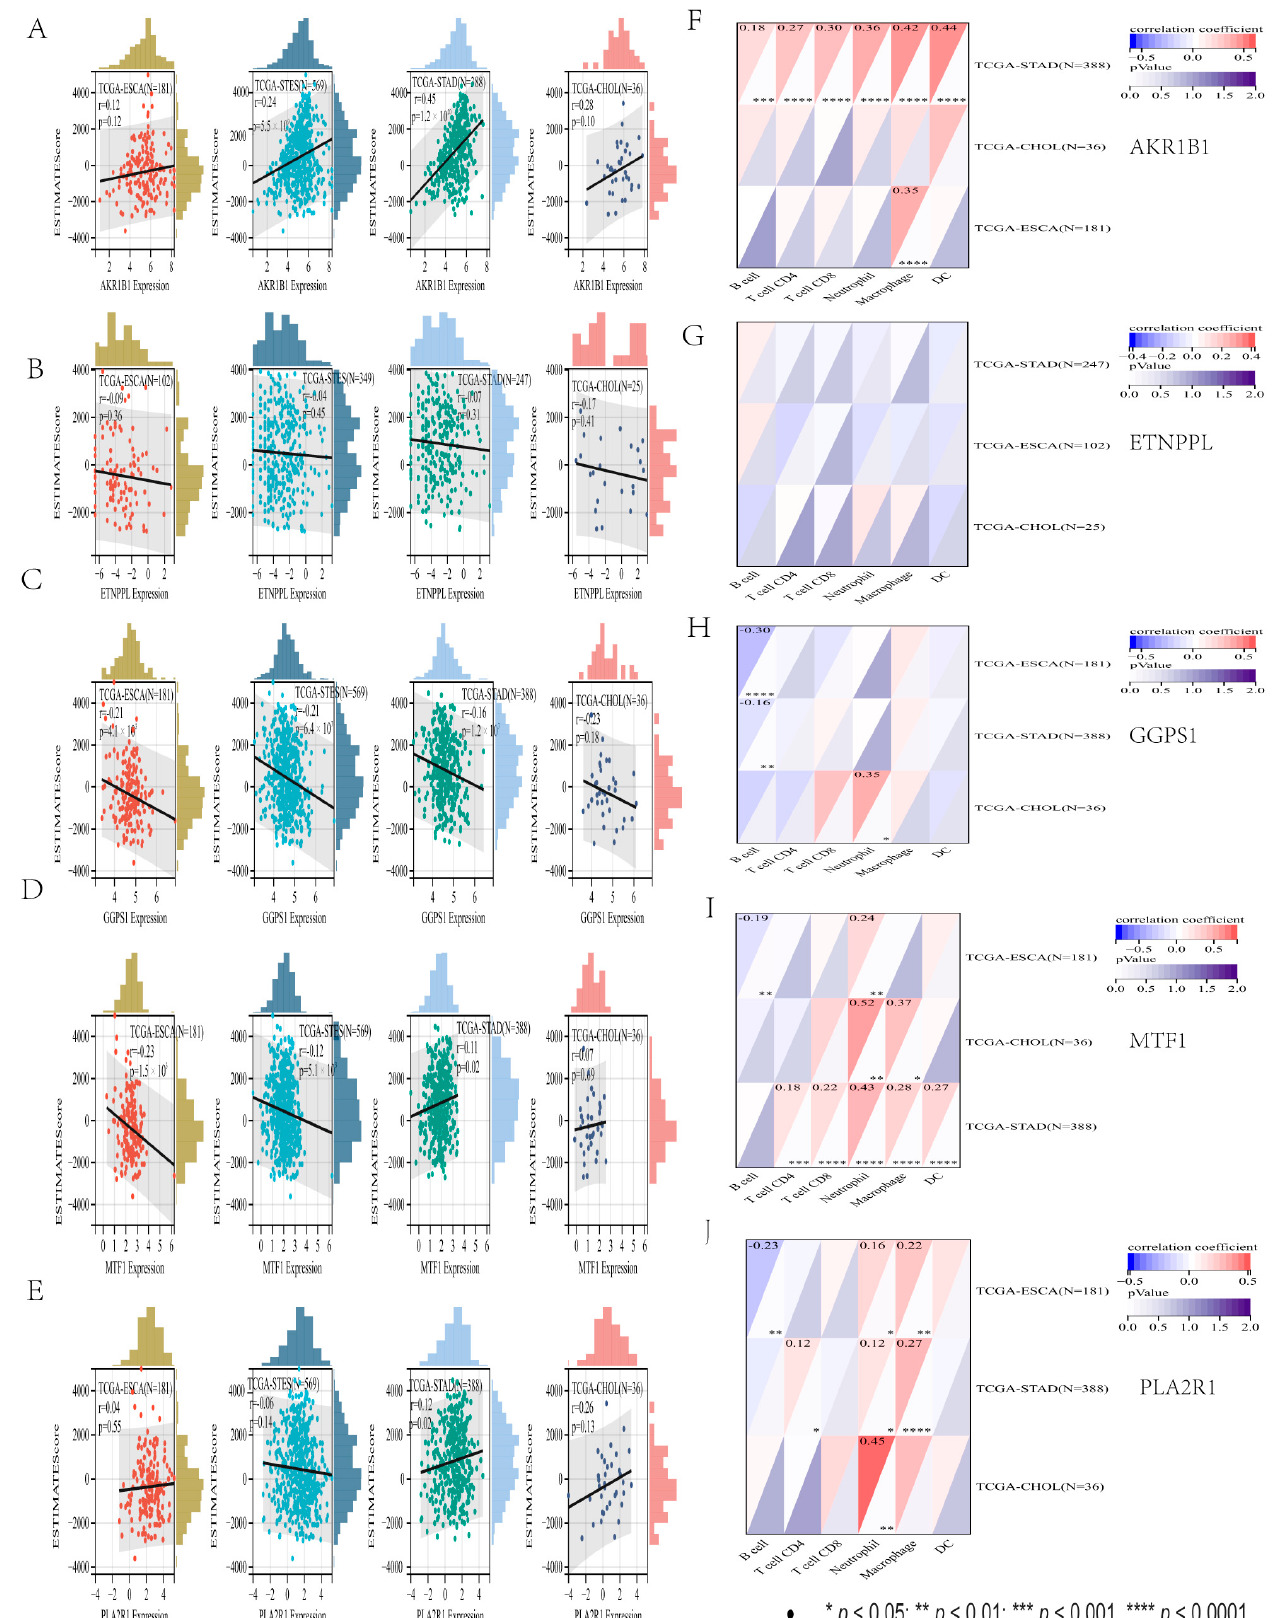
Figure 9. Five genes in gastrointestinal cancer differential and immune infiltration analysis. ( A – E ) The immune infiltration score. ( F – J ) The immune cells score.